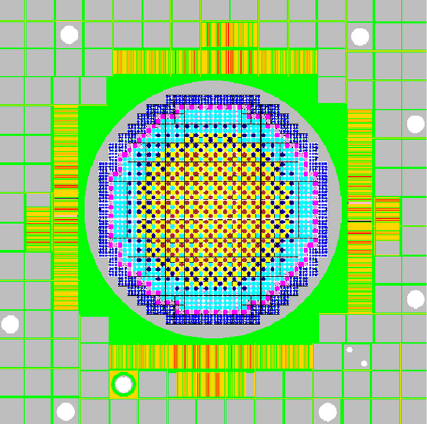
Fig. 2. The ERMINE5/ZONA1 core con fi guration.